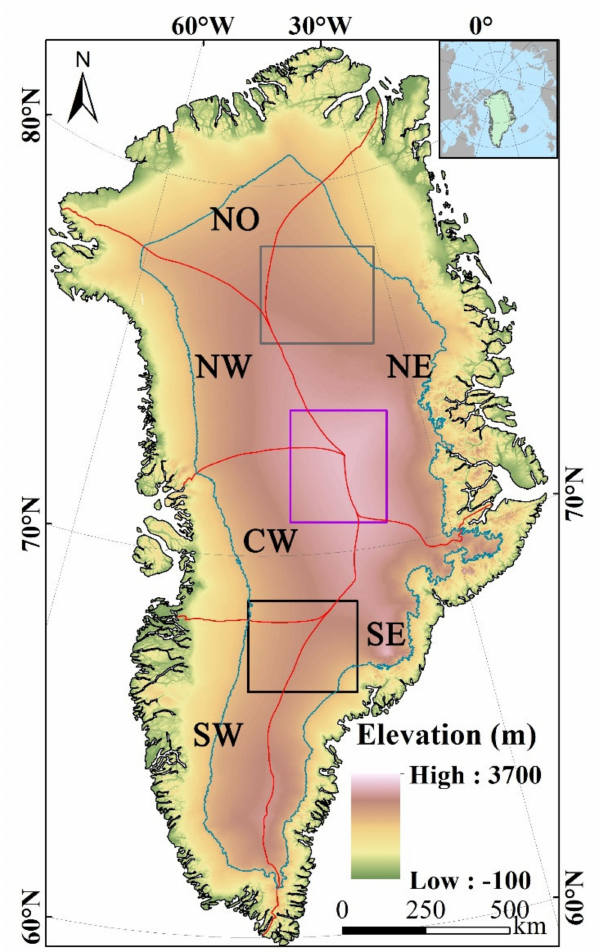
Figure 1. The TanDEM-X DEM of Greenland. The red lines mark the basin boundaries. The blue line indicates an elevation of 2000 m. NO and others are the names of basins. The black frame is region 1, the purple frame is region 2, and the gray frame is region